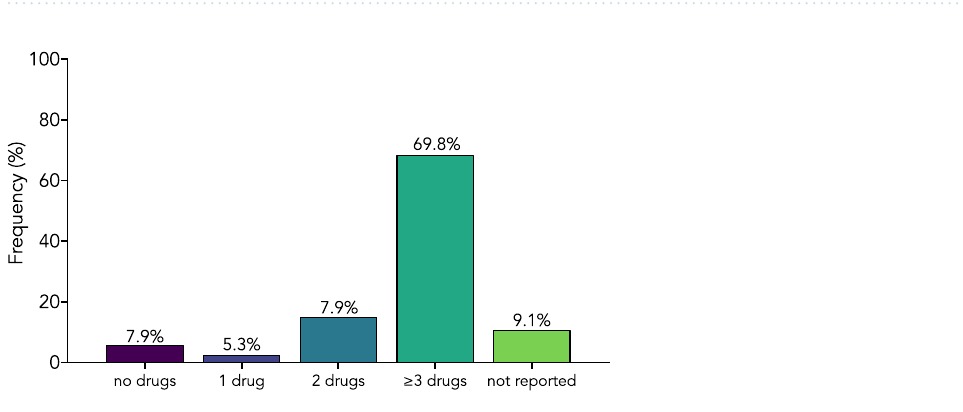
Figure 5. Anticancer drugs in patients with pseudocirrhosis. Anticancer drugs reported in case reports and in case series. Values are expressed as frequencies.